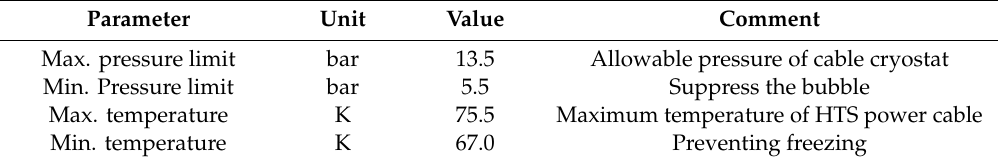
Table 3. Allowable operating range of cooling system for triaxial HTS power cable.